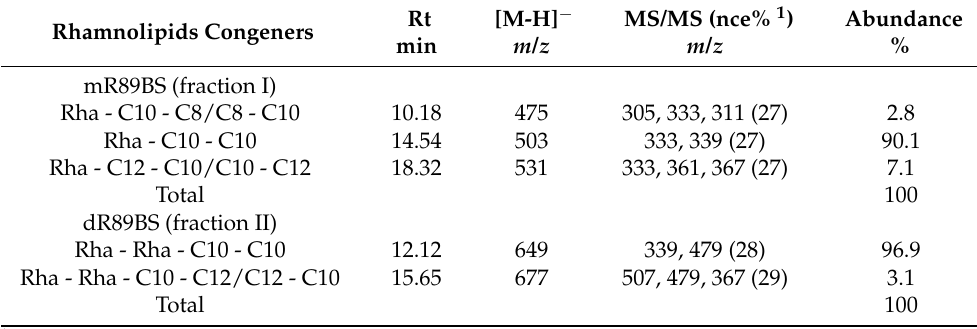
Table 1. LC-MS/MS MRM parameters for rhamnolipids congeners analysis and relative abundance in purified fractions.